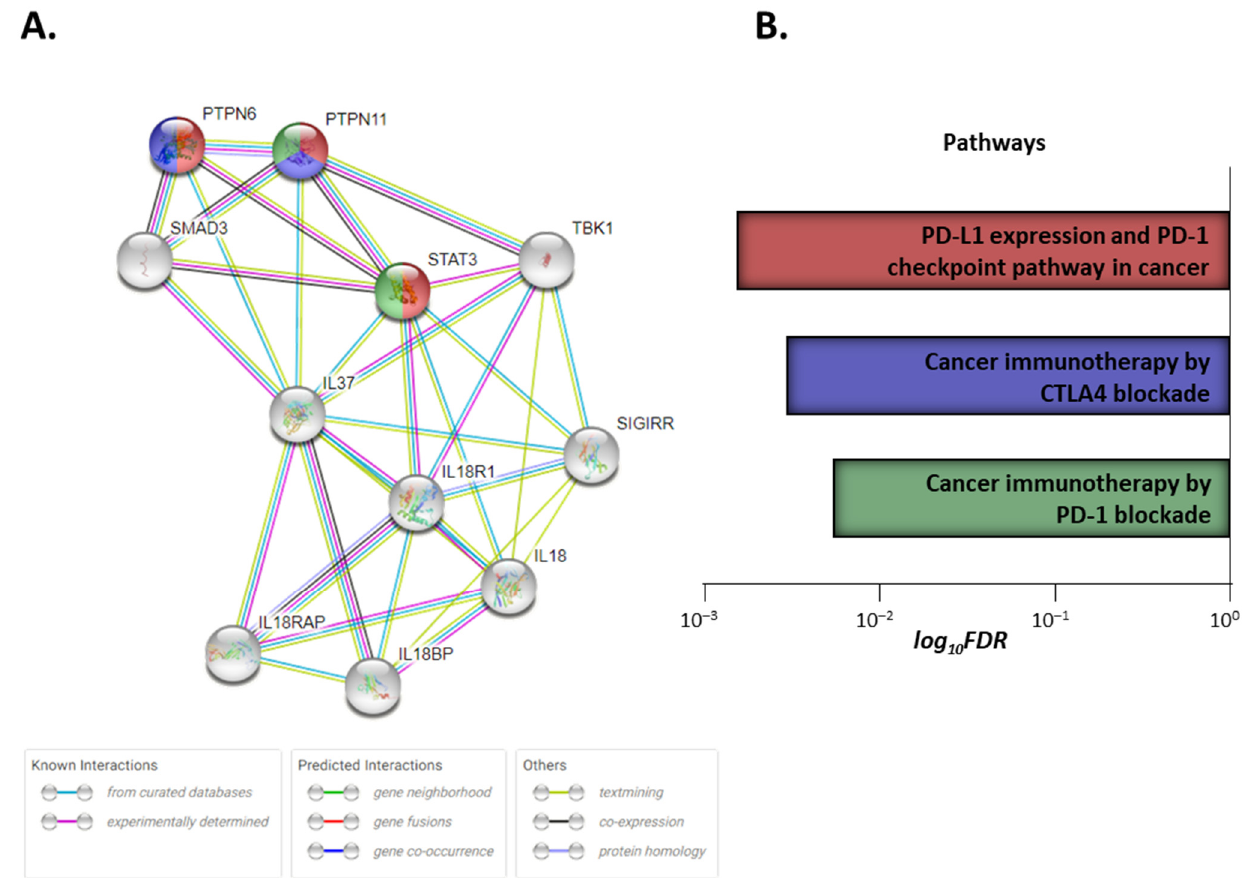
Figure 6. Network of interactions (exported by STRING portal [37]) ( A ) among proteins involved in IL-37 signaling and other proteins implicated in PD-1/PD-L1 and CTLA-4 immune-checkpoint pathways ( B ), as attested using the STRING (Search Tool for the Retrieval of Interacting Genes/Proteins). The above pathways share common nodes (each color corresponds to different pathway; nodes marked with more than one color belong to equal number of pathways). Edges represent protein–protein associations: known interactions, predicted interactions, or other associations. Level of confidence for minimum required interaction score was 0.4. Data were obtained from https://string-db.org [37] (accessed on 3 October 2022).